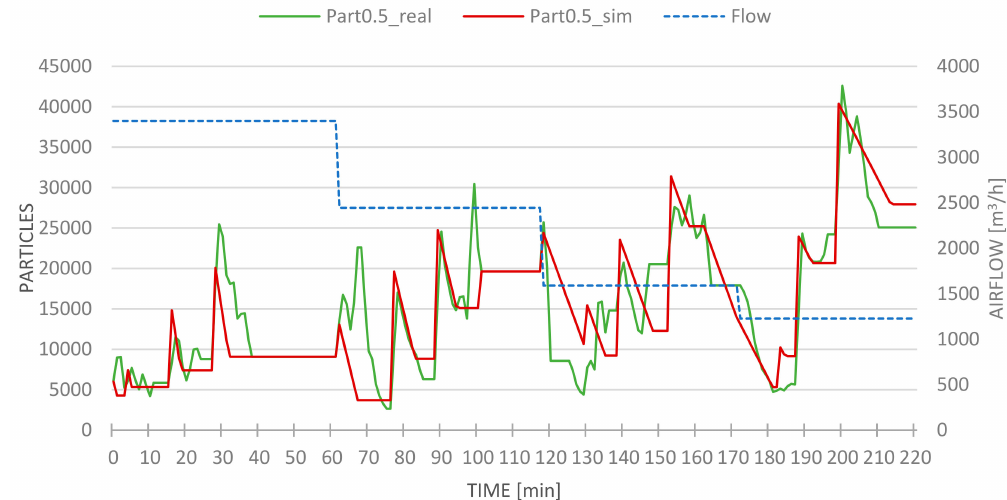
Figure 6. Simulated particles. Size: 0.5 µ m. Red line: simulated particles. Green line: real particles. Blue line: airflow.